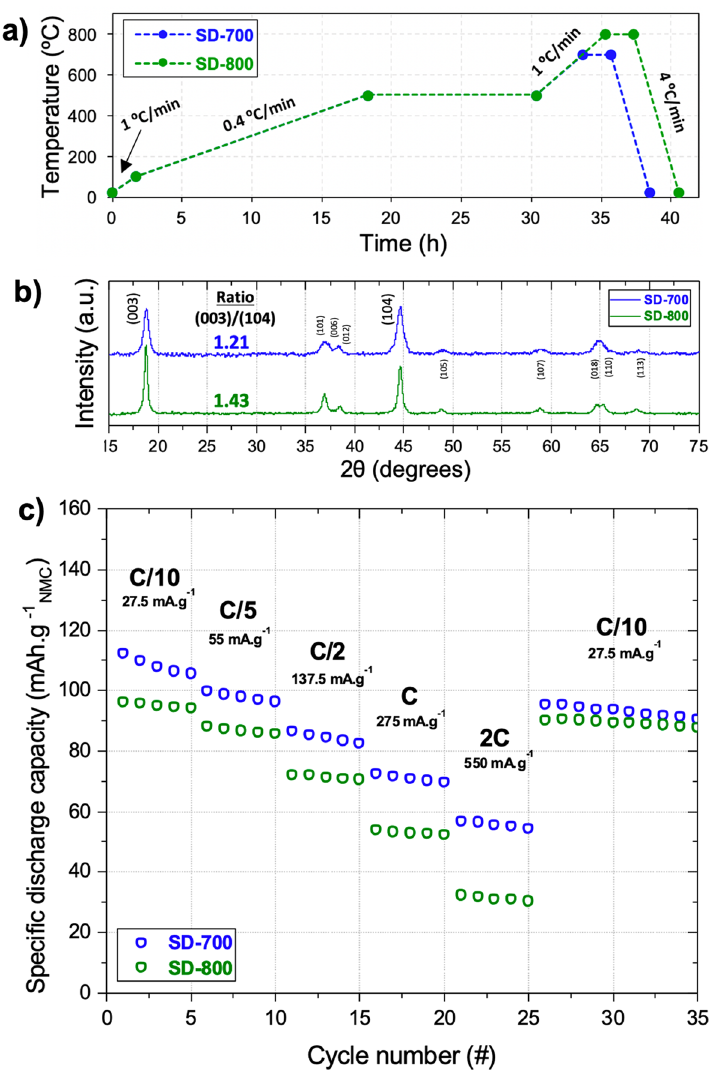
Figure 5. ( a ) Temperature profile to synthesize NMC 111 from two 3D printed items including a slower heating rate step and synthesized at a maximum temperature of 700 or 800 °C. ( b ) XRD diffractograms of samples SD-700 and SD-800 NMC 111 materials. The peak normalization is shown in Fig. S4. ( c ) Rate capability tests results for the two NMC 111